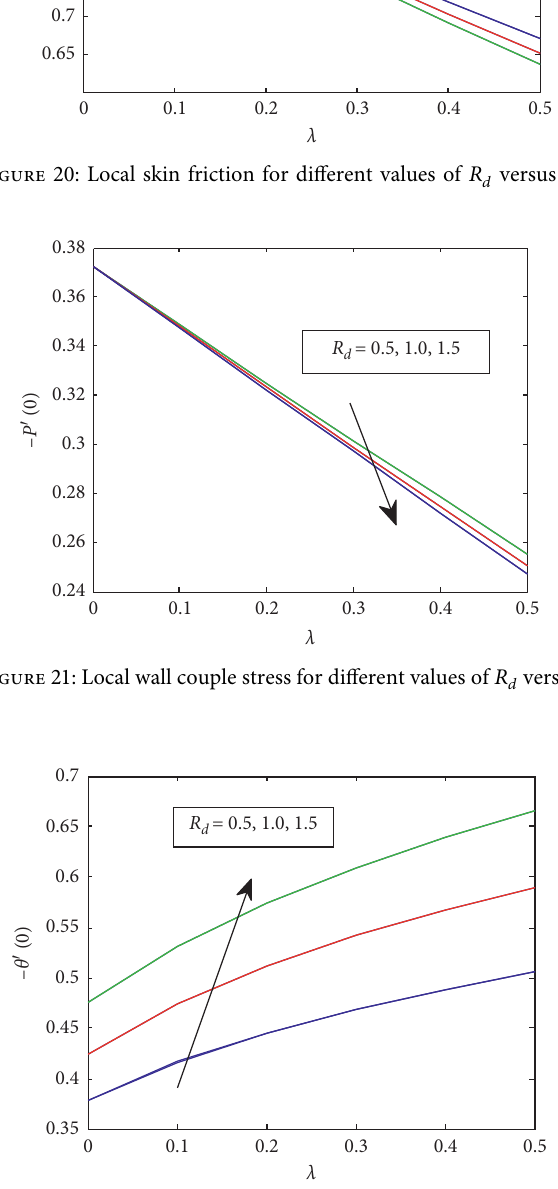
Figure 22: Local Nusselt number for different values of R E .